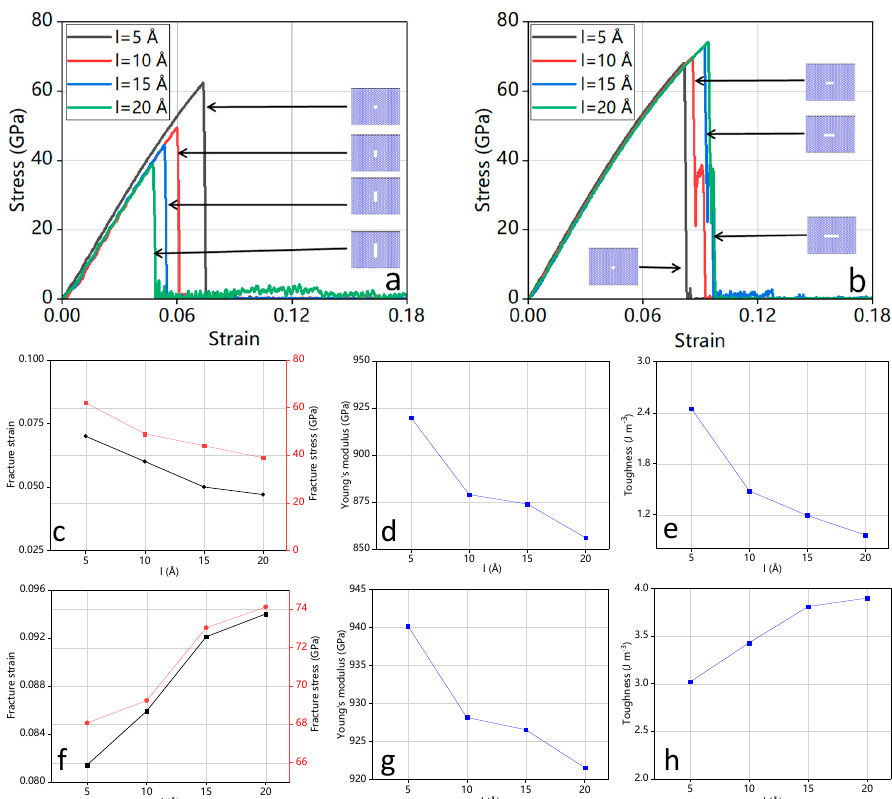
Figure 4. Analysis of mechanical properties of bilayer graphene with rectangular cracks of different widths. ( a , b ) show stress–strain relationships for cracks oriented along the y - and x -axes, respectively. ( c – e ) present fracture strain, fracture stress, Young’s modulus, and toughness of the samples with cracks along the x -axis, and ( f – h ) along the y -axis. The results demonstrate the crack orientation has a great impact on the mechanical property of the bilayer graphene.